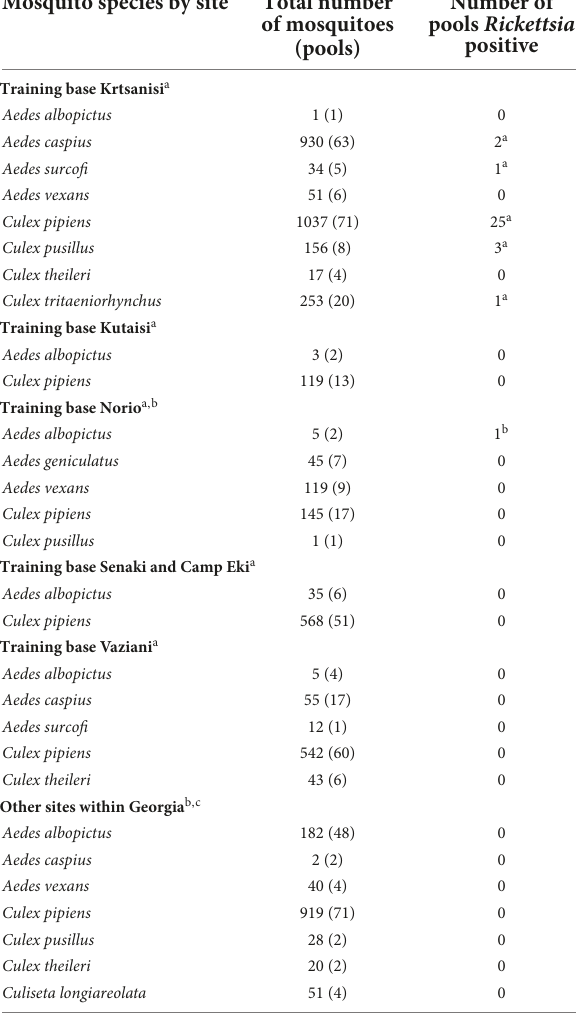
TABLE 2 Summary of mosquitoes collected across Georgia from 2018 to 2019 utilized in this study. Mosquito species by